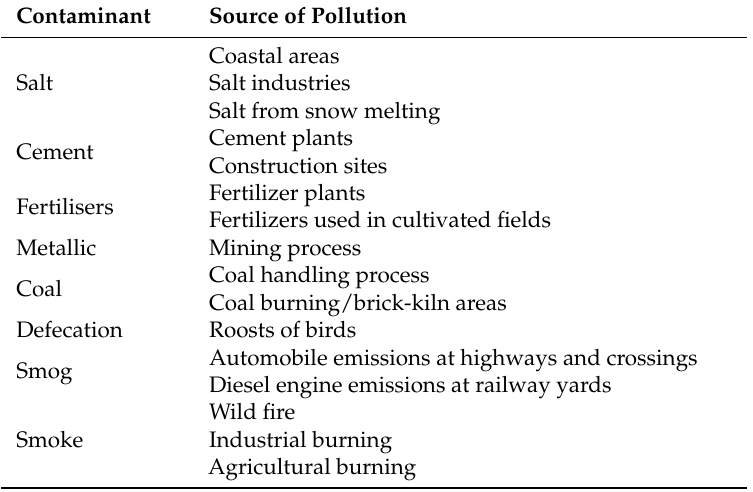
Table 3. The typical pollutants affecting the HV insulators and their sources [37].